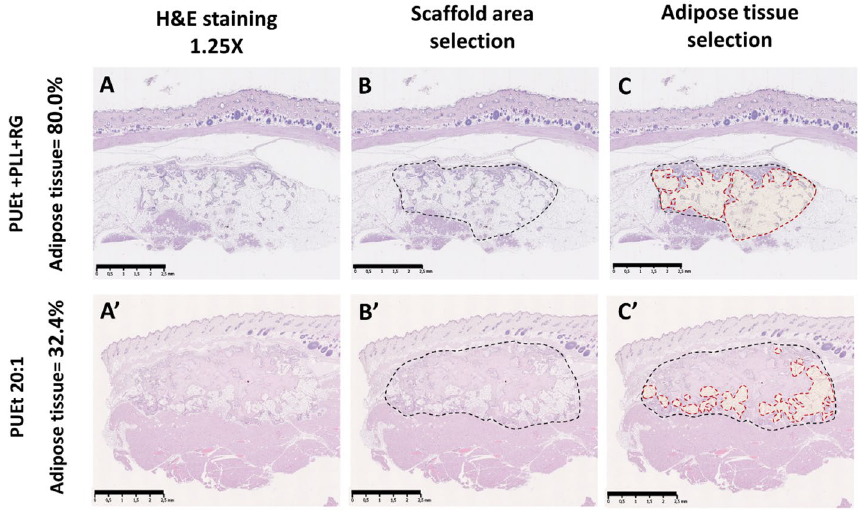
Figure 3. Schematic representation of the method adopted for semi-quantification of adipose tissue (%). Scanned histological sections was digitally processed by means of NDP.view2 software (Hamamatsu Photonics K.K., Hamamatsu City, Japan) to obtain (1.25 × magnitude) histological images. ( A , A ’) H&E stained histological images belonging to the replicas from the experimental groups: PUEt + PLL + RG (an example for high- adipose tissue %), PUEt 20:1 (an example for low-adipose tissue %), respectively; ( B , B ’) manual selection of the scaffolds region into the histological images, circumscribed by the black dashed line, to calculate the pixels corresponding to the scaffolds area (region of interest ROI) by means of analysis program ImageJ v1.52a (National Institutes of Health, Bethesda, Maryland, USA). The scaffold/host tissue interface is easily detectable where the polymeric matrix is no longer present. ( C , C ’) The regions of adipose tissue inside the selected scaffold regions, circumscribed by the red dashed line, were selected exploiting the characteristic shape of adipose cells (rounded white) which allowed to distinguish adipose tissue from the remaining types of soft tissue colonizing the scaffold. The sum of pixels from adipose tissue regions within the same ROI is multiplied by 100 and divided by the pixels of the ROI to calculate the % of adipose tissue in each histologic section. Scale bars = 2.5